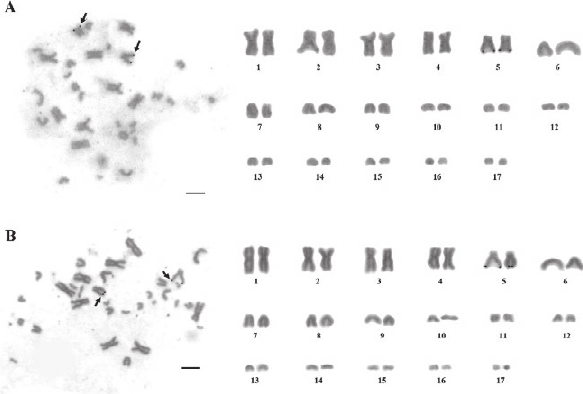
Figure 3. Metaphase chromosome plates and karyotypes of G. nuta- phandi (A) male (B) female by Ag-NOR banding technique. Scale Bars = 10 µm.